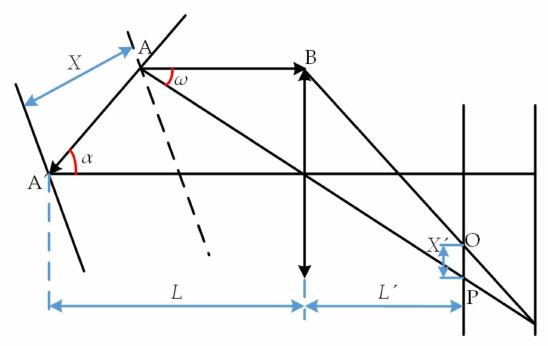
Figure 7. Schematic of light spot